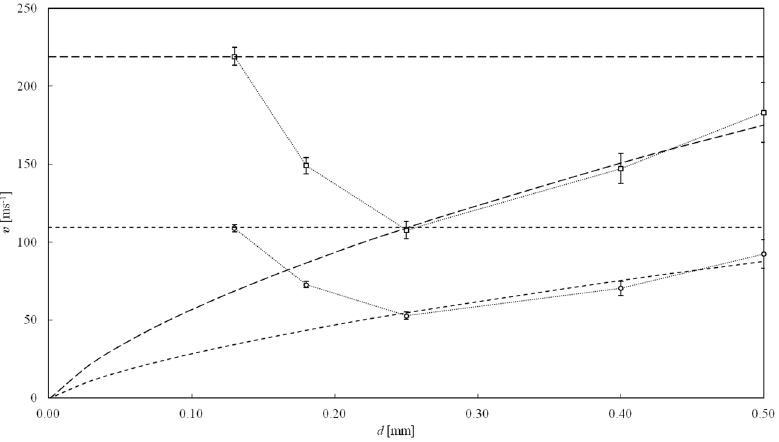
Figure 4. Experimentally determined dependence of the mean cross-sectional flow speed in the tube with length 20 mm on internal diameter d for inlet pressures 24 MPa (square points) and 6 MPa (circle points), which can be compared with theoretical curves according to (4), where the long and short dashed lines stands for 24 MPa and 6 MPa respectively. The corresponding horizontal lines represent the maximum theoretical values of the outflow speed without energy losses caused by contraction and friction for the inlet pressures. The dotted connectors for both set of data are inserted only to indicate the affinity of points for a given pressure value and does not represent the true dependence between